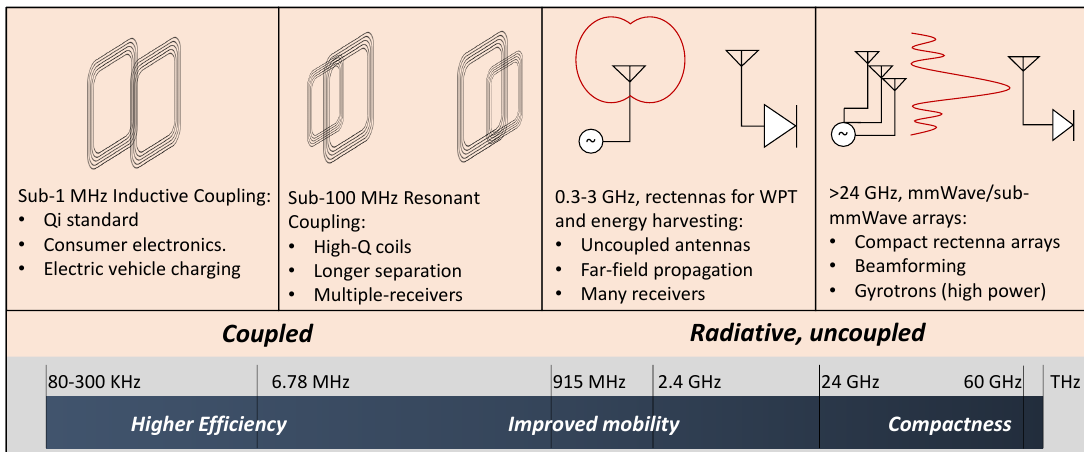
Figure 1. The current WPT research spectrum: sub-MHz Qi-standard WPT [15], coupled magnetic resonance [16], rectennas for UHF WPT [17,18], mmWave, sub-mmWave and THz optical rectennas